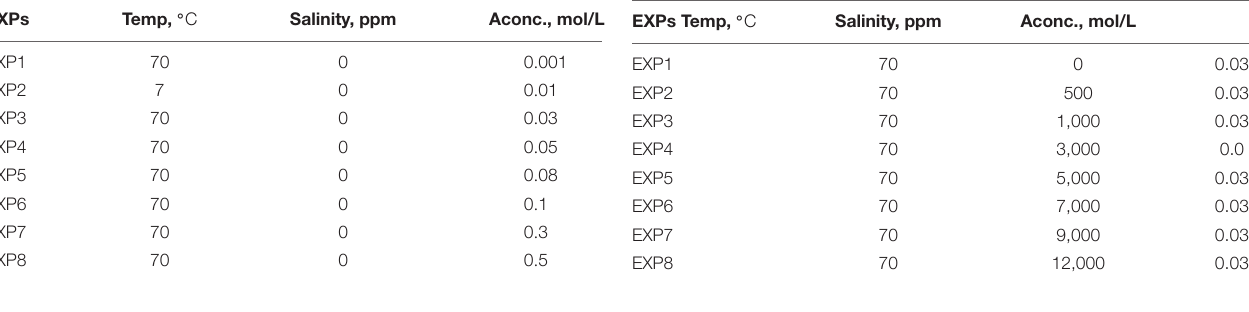
TABLE 13 | Na 2 CO 3 salinity trend study experiment